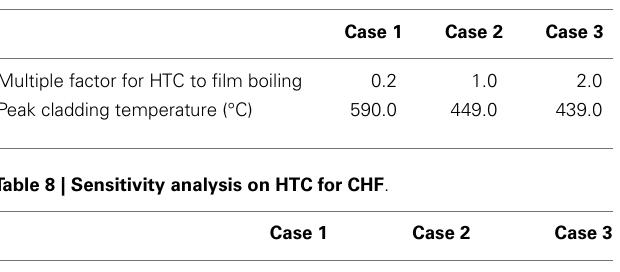
Table 7 | Sensitivity analysis on HTC to film boiling .